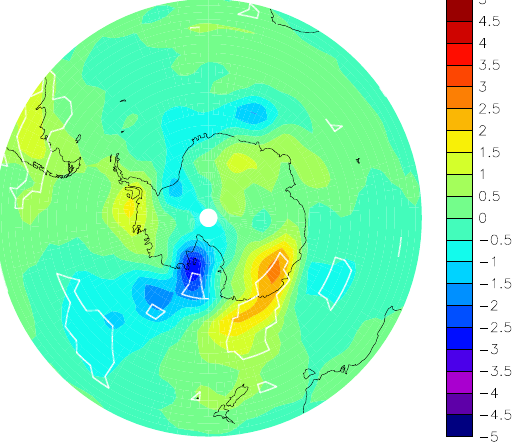
Fig. 5. Southern Hemisphere JJA surface temperature difference (K), 1T = T S − EPP − T S − noEPP . Red/blue colours indicate posi- tive/negative